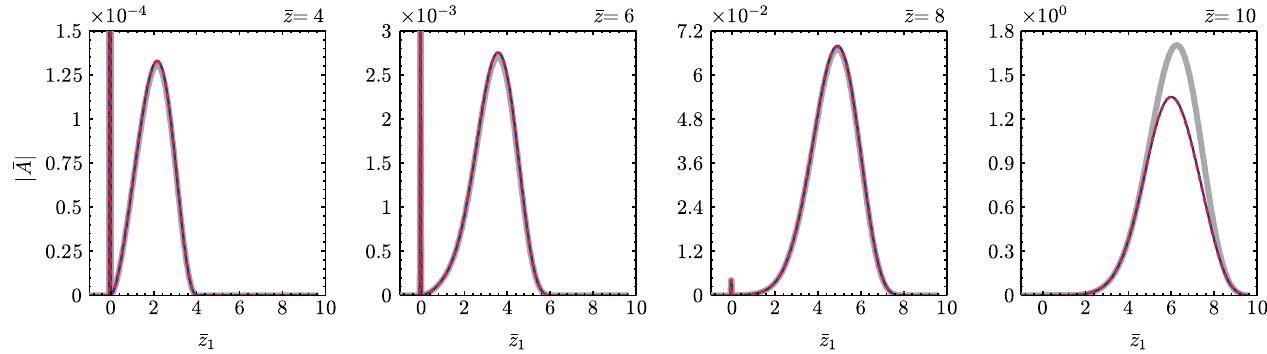
FIG. 2. Evolution at various (cid:3) z locations of the intensity of the radiation A for a system seeded with a single ultrashort spike of rms = 8 ) located at (cid:3) z 1 ¼ 0 . The thick gray curve is from the analytical model, the solid blue from width (cid:3) z 1 ¼ (cid:3) (cid:6) 10 (cid:5) 3 (corresponding to (cid:1) R the non-SVEA code AURORA , and the dashed red curve from the conventional SVEA code. The latter almost perfectly overlaps the blue